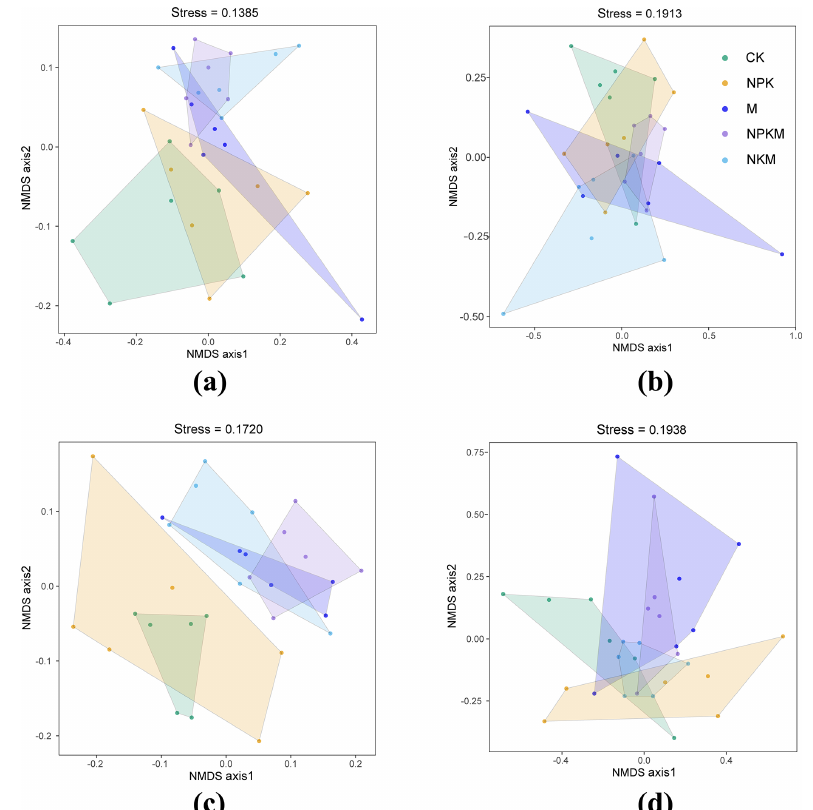
Figure 5. Nonmetric multidimensional scaling (NMDS) ordination of the microbial community by comparing with Bray–Curtis distance similarities based on the abundance of OTUs. Lowercase letters mean different classification ( a – bacteria in bulk soil; b – fungi in bulk soil; c – bacteria in rhizosphere soil; d – fungi in rhizosphere soil).